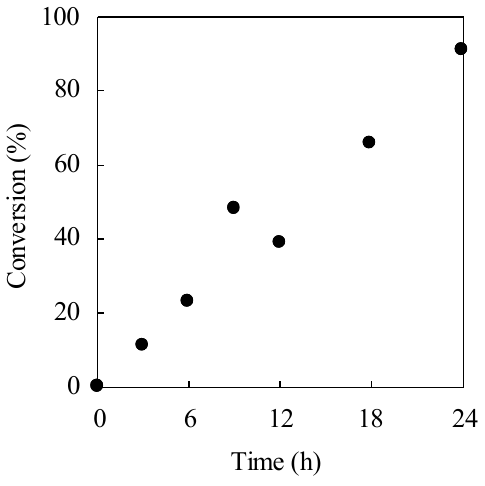
Figure 13. The time-conversion plots of the allyloxystyrene units for the photorearrangement. [copolymer] = 1.64 0